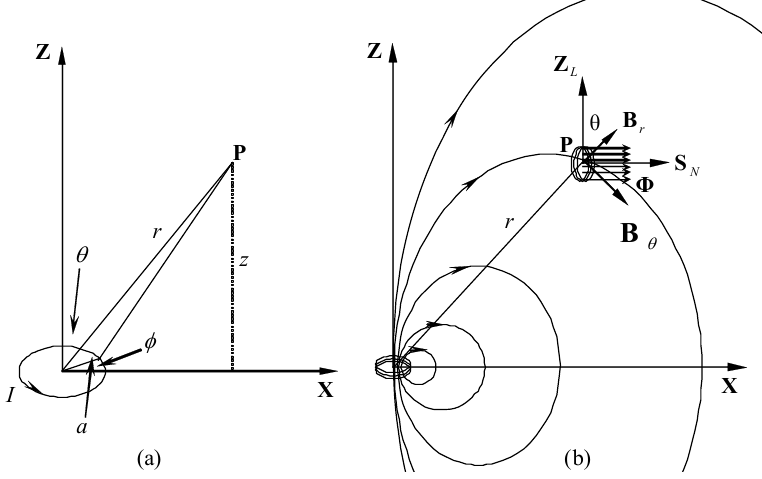
Figure 1. Illustration of magnetic fields: (a) a point P located at distance r from a magnetic dipole; (b) the magnetic flux density linked by the coil at position P (adapted from